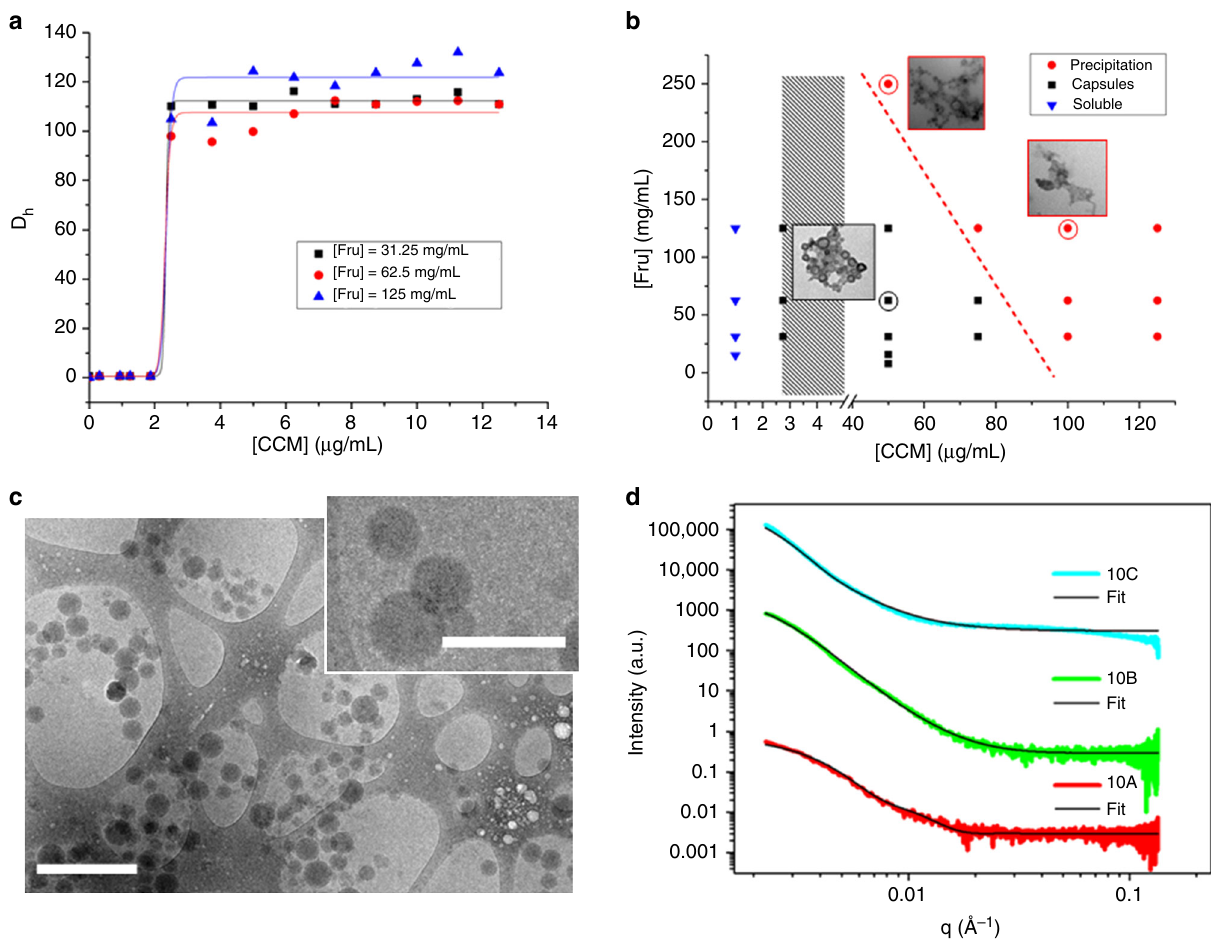
Fig. 2 Analysis of size and structure of the nanocapsules. a Curcumin concentration dependence of the nanoparticle size, b phase diagram of fructose – curcumin nanoparticles; grey bar denotes area of aggregates and/or capsules, c cryo-transmission electron microscopy (TEM) of the nanoparticles prepared with [Fructose, Fru] = 10 mg/mL and [Curcumin, CCM] = 60 μ g/mL (scale bar is 500 nm, scale bar in inset is 200 nm) and d small-angle X-ray scattering (SAXS) measurements with a fi xed fructose concentration (10 mg/mL) and varying curcumin concentration (where A = 20 μ g/mL, B = 60 μ g/mL and C = 80 μ g/mL) and their fi tting